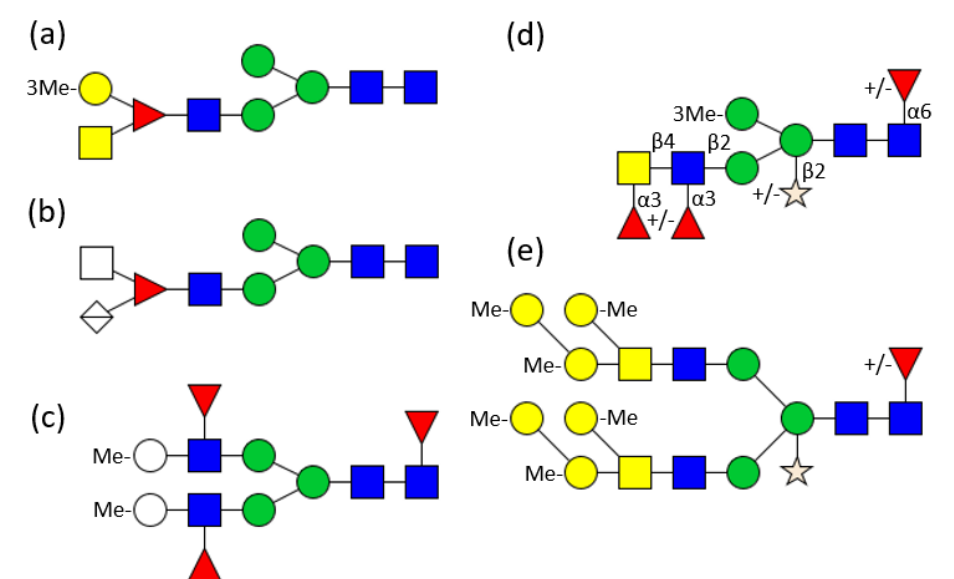
Figure 3. Examples for hemocyanin N-glycan structures from different molluscs. ( a ) 7 RtH2-e of Rapana thomasiana [31]; ( b ) RvH 1 and RvH 2 of Rapana venosa [32,33], ( c ) HtH1 of Haliotis tuberculata [34], ( d ) Biomphalaria glabrata [35], ( e ) Helix pomatia [25,36]. For the symbols key see Figure 1.